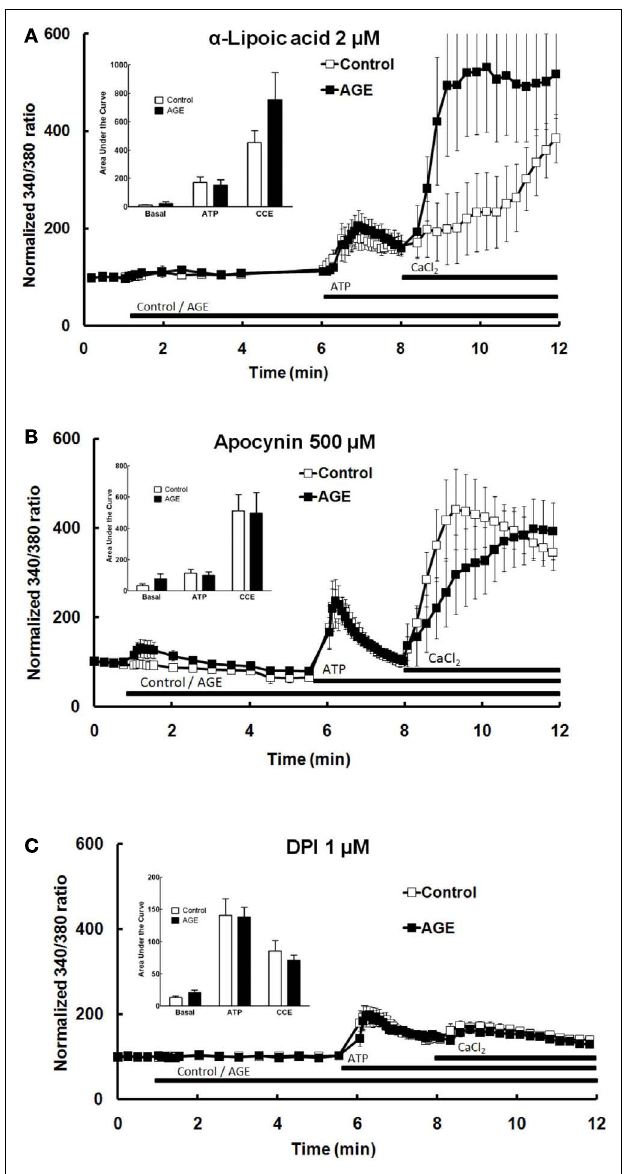
FIGURE 7 | α -Lipoic acid (A), apocynin (B), and DPI (C) each abolished the effects ofAGEs on Ca 2 + signaling in BAEC. Points and columns represent the mean ± SEM of 6–11 recordings.